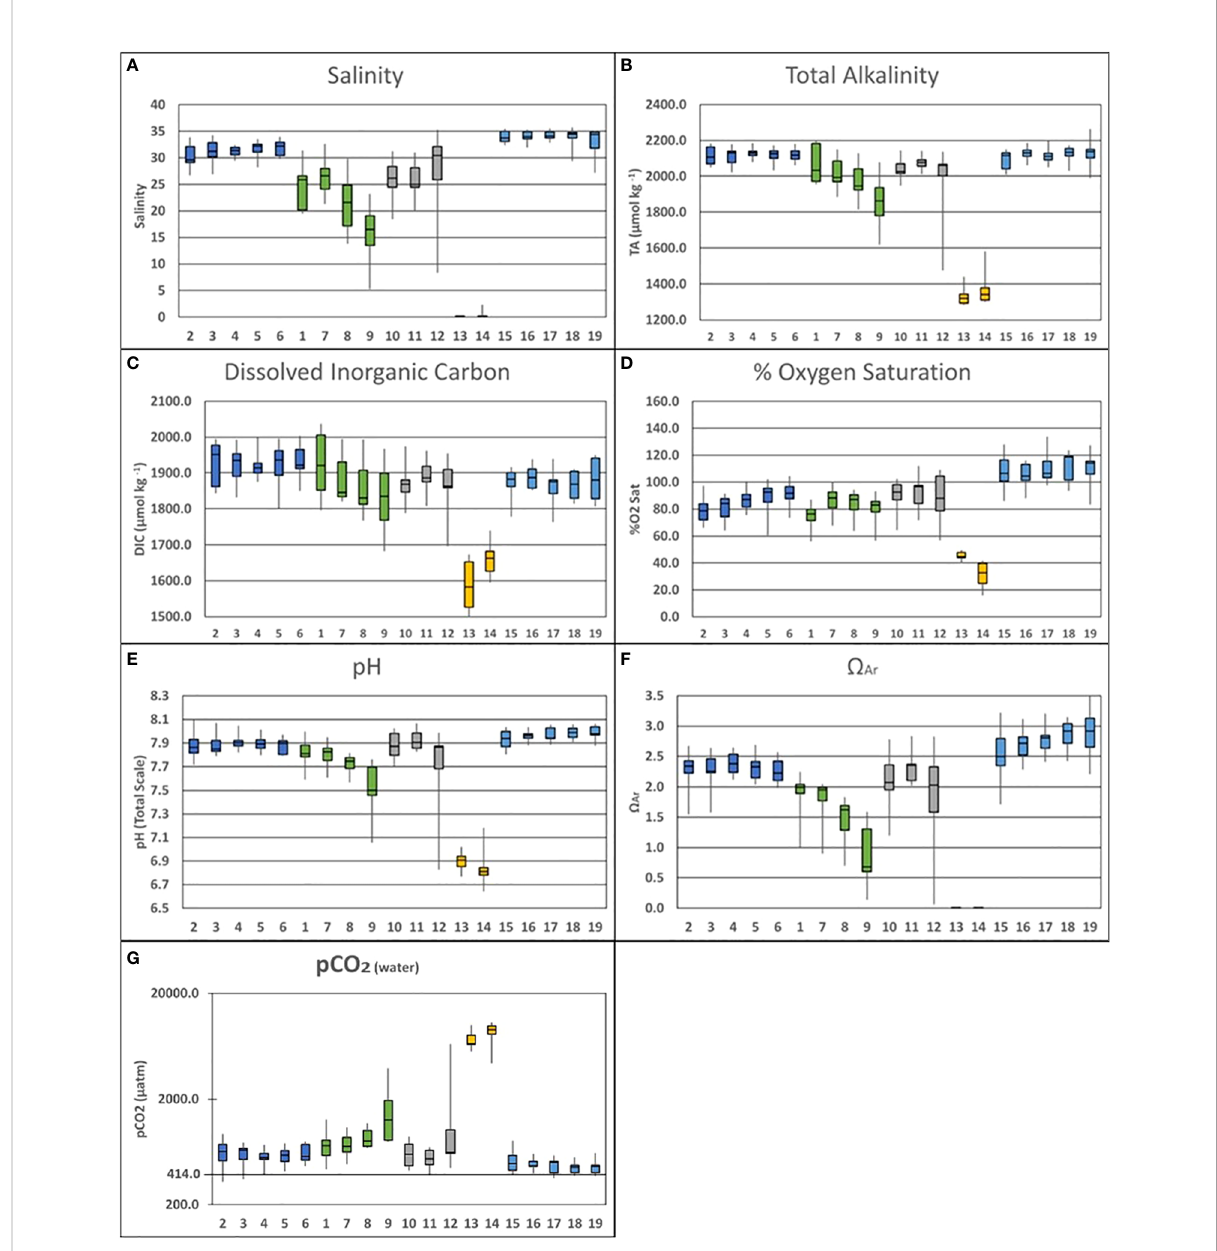
FIGURE 3 Vertically and temporally averaged data [ (A) Salinity; (B) Total Alkalinity; (C) Dissolved Organic Carbon; (D) % O 2 Saturation; (E) pH; (F) W Ar (G) pCO 2(water) ] separated by sampling stations and organized into the designated spatial groups: Pond Center (Dark Blue: Stations 2-6); Fresh Water Lens (Green: Stations 1, 7, 8 & 9); North Pond (Gray: Stations 10, 11 & 12); Stream Water Source (Yellow: Stations 13 & 14); Bay Water Source (Light Blue: Stations